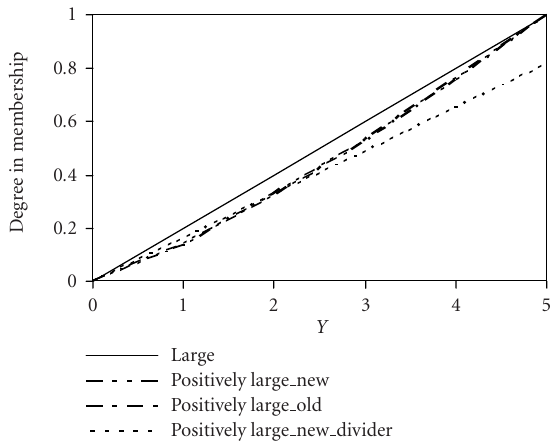
Figure 3.6. Schematic illustration of linguistic hedge